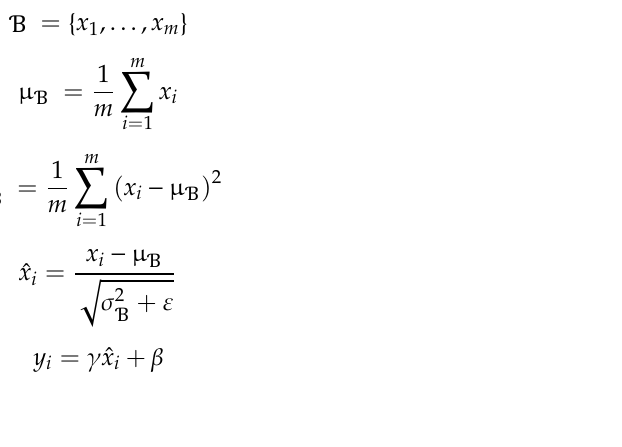
Table 1. Summary of input features and output brightness temperatures (BTs) in the fully connected “deep” neural network algorithm with the Community Radiative Transfer Model (FCDN_CRTM). SZA: satellite zenith angle.